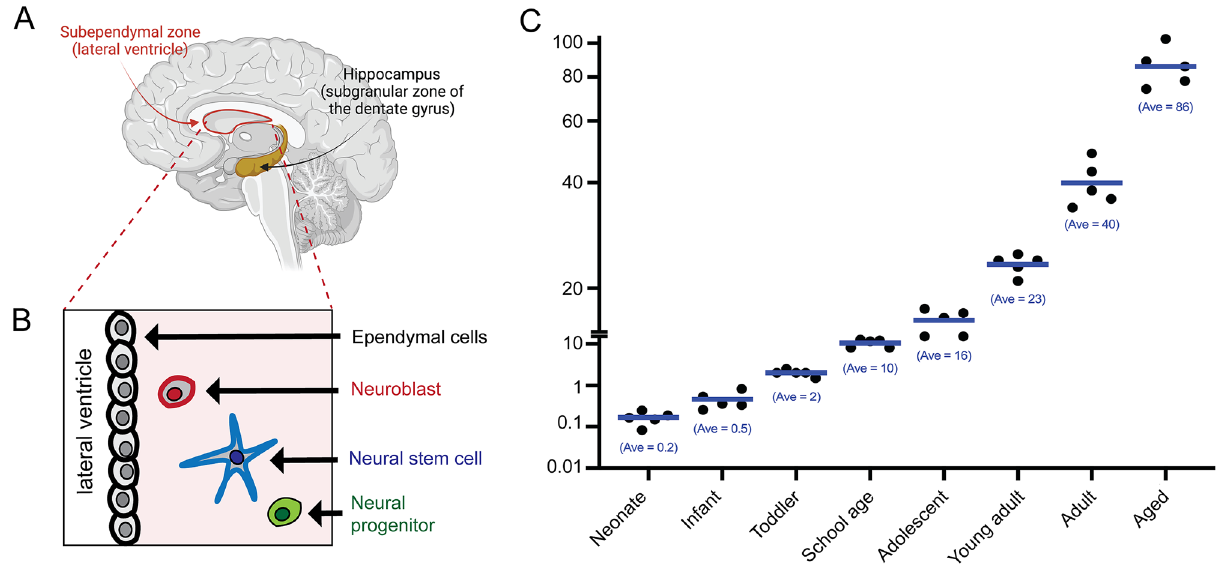
Figure 1. Cohort used to generate a transcriptional atlas of gene expression within the human SEZ grouped by age. ( A ) Schematic of a mid-sagittal view of a human cerebral cortex, depicting the two main adult neurogenic niches, the subependymal zone (SEZ), and the subgranular zone of the hippocampal dentate gyrus. ( B ) Some of the principal cell types found within the SEZ. ( C ) Graph showing the age of the samples from our RNA sequencing cohort. Samples were grouped into the following groups: neonate, infant, toddler, school age, adolescent, young adult, adult and aged adult. The average age of the samples in years is shown below the data points for each group. We sequenced dissected SEZ tissue from five samples in each age group. Panel ( A ) was generated using